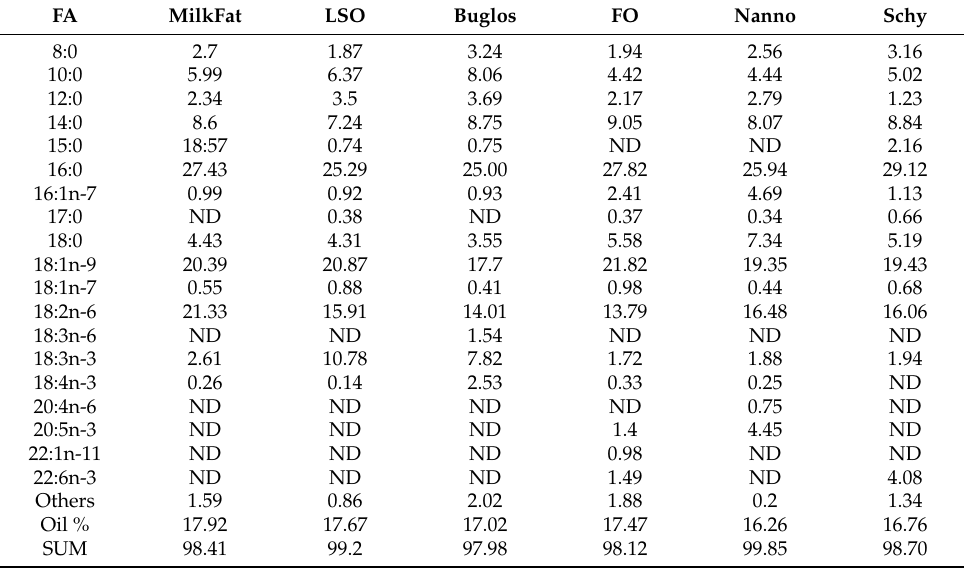
Table 1. Fatty acid (FA) profile (%) in different